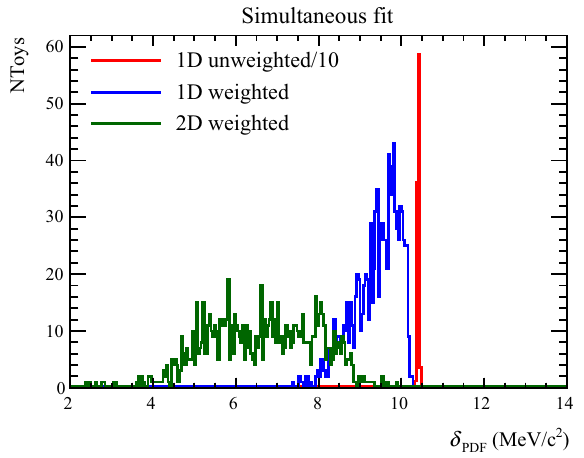
μ μ fit without weighting, p fit with weighting, ( p , η ) fit with weighting. T T The one-dimensional unweighted distribution is arbitrarily scaled down by a factor of ten μ T